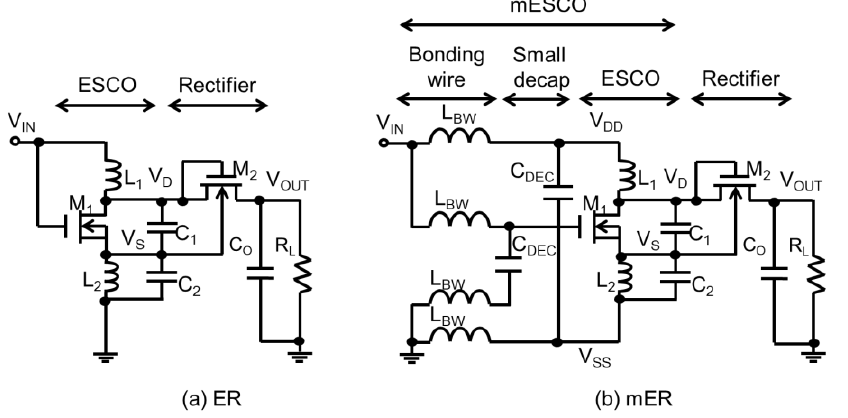
Figure 3. ( a ) Enhanced swing Colpitts oscillator (ESCO) followed by rectifier (ER); ( b ) ER with LC